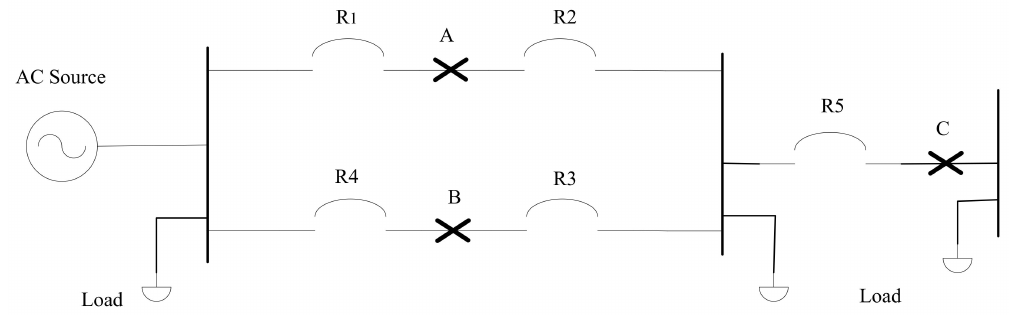
Figure 6. A single-ended parallel distribution power system (Case 2). Table 4. Calculations of I relay (current through relay) and α p (constant) (Case 2). Faulty